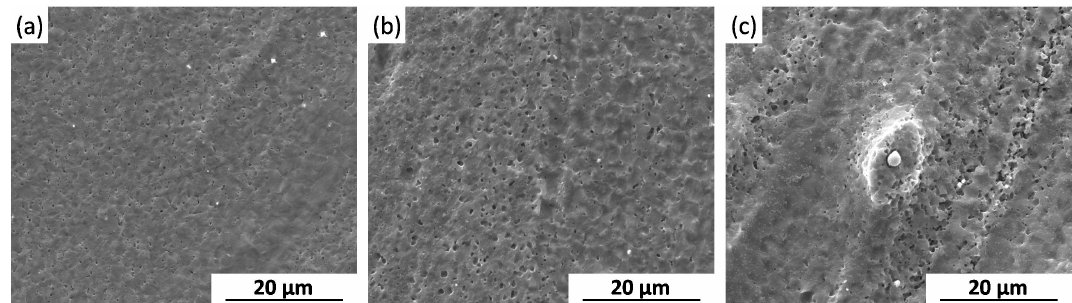
Figure 16. Surface morphologies of FSP specimens after different immersion time intervals in SBF: ( a ) 3 h; ( b ) 6 h; and ( c ) 12 h (without corrosion products).